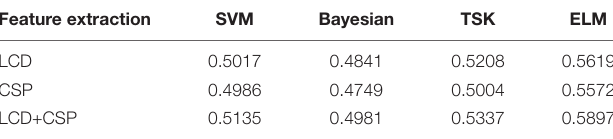
TABLE 3 | Kappa coefficient of Data Sets